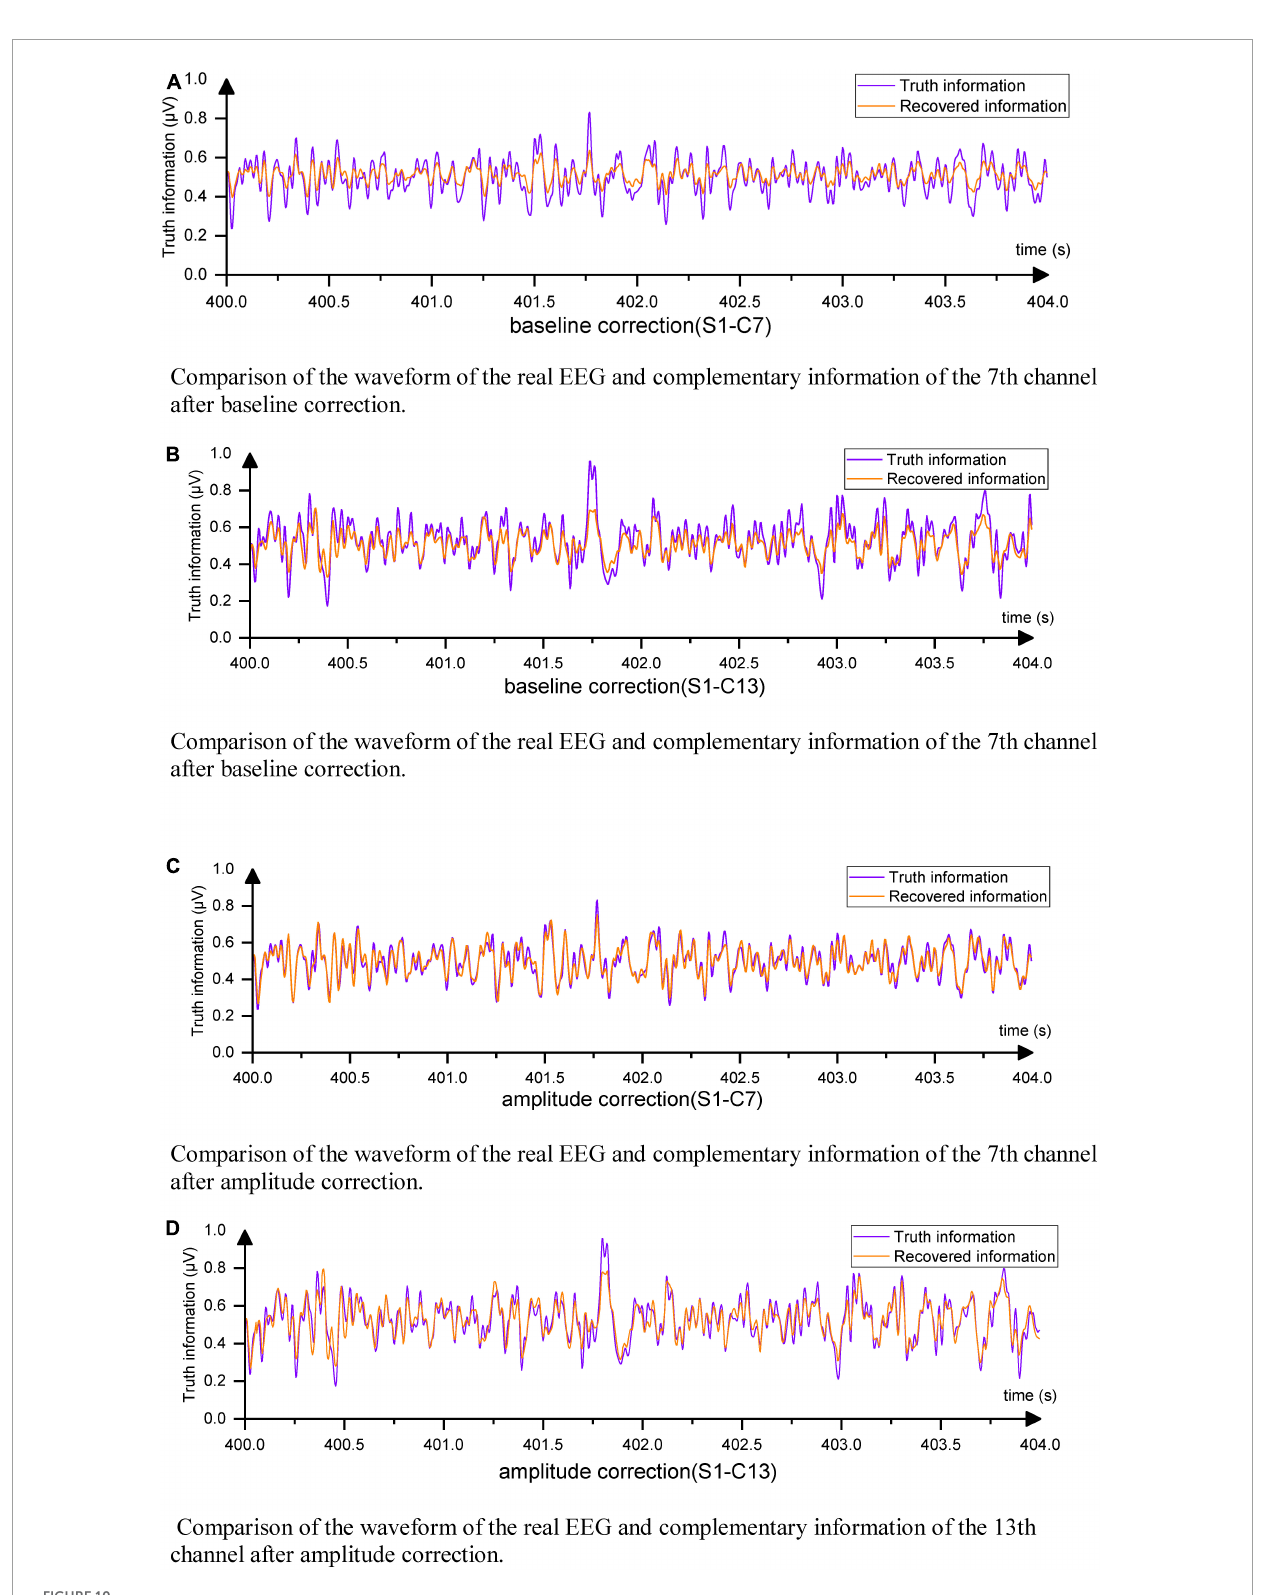
FIGURE10 EEG waveforms from direct output. (A) Comparison of the waveform of the real EEG and complementary information of the 7th channel after baseline correction. (B) Comparison of the waveform of the real EEG and complementary information of the 7th channel after baseline correction. (C) Comparison of the waveform of the real EEG and complementary information of the 7th channel after amplitude correction. (D) Comparison of the waveform of the real EEG and complementary information of the 13th channel after amplitude